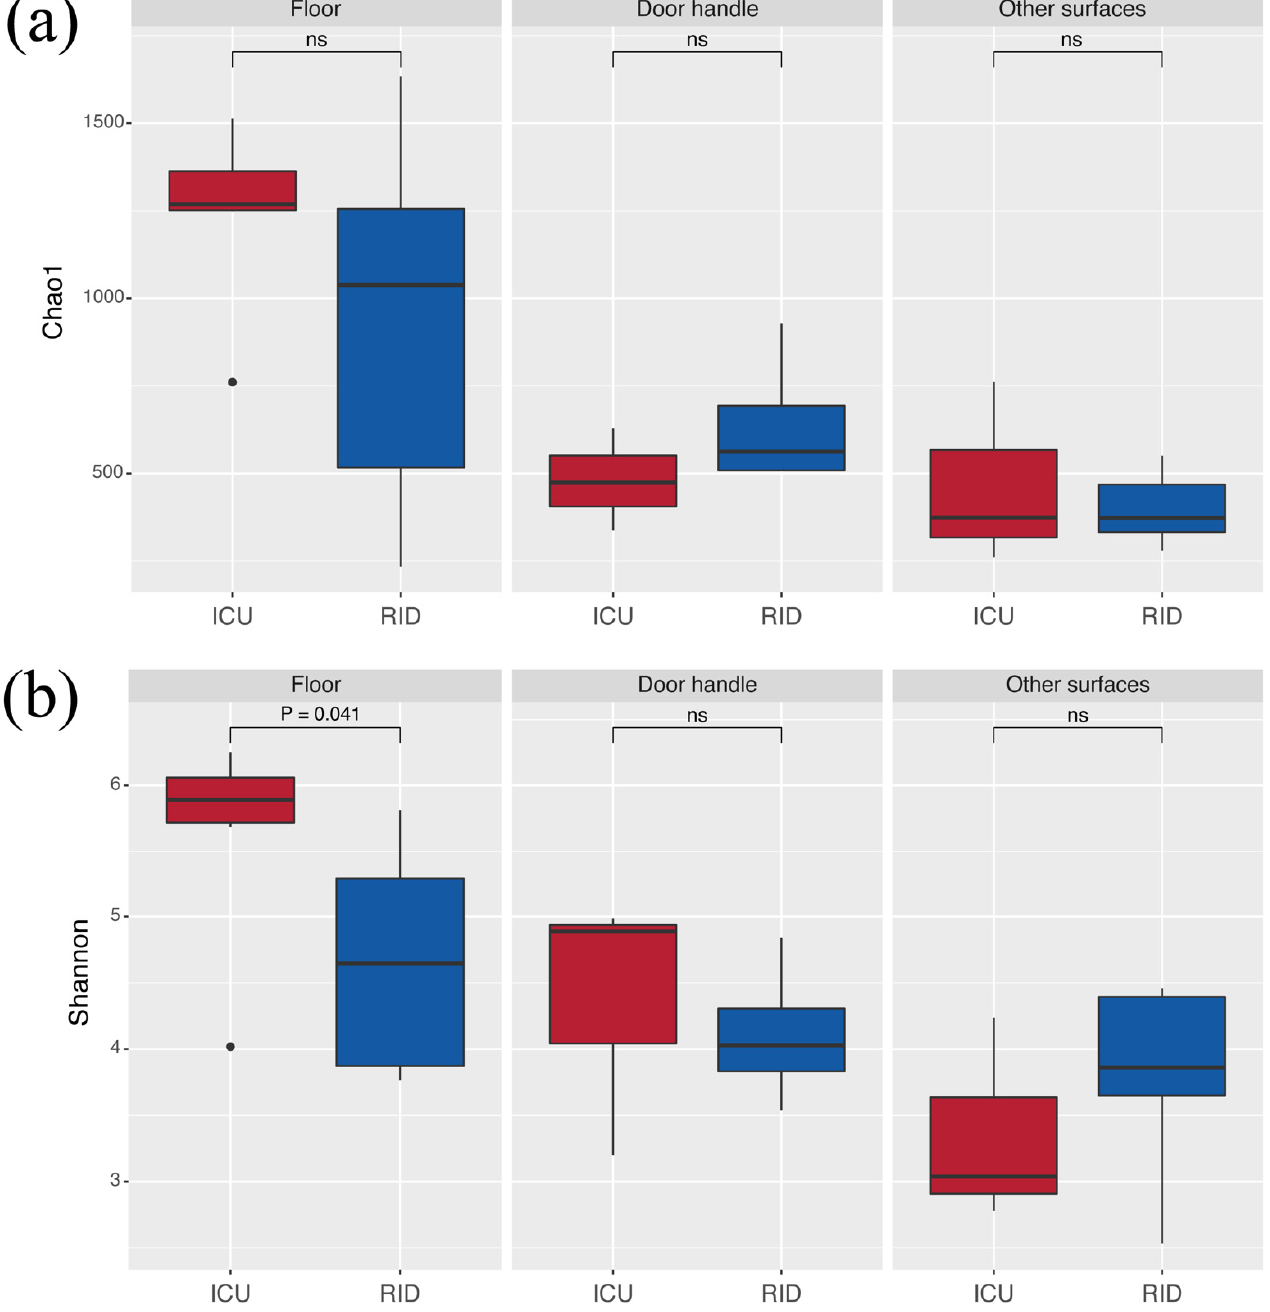
Figure 2. Dependence of α -diversity on the department and surface type: ( a ) diversity measured by the Chao1 index; ( b ) diversity measured by the Shannon index. ICU—Intensive Care Unit; RID—Respiratory Infections Department. Box plots with middle line denote the median, the box denotes the interquartile range (IQR), and 1.5 IQR ranges (whiskers). Ns—no significance detected.